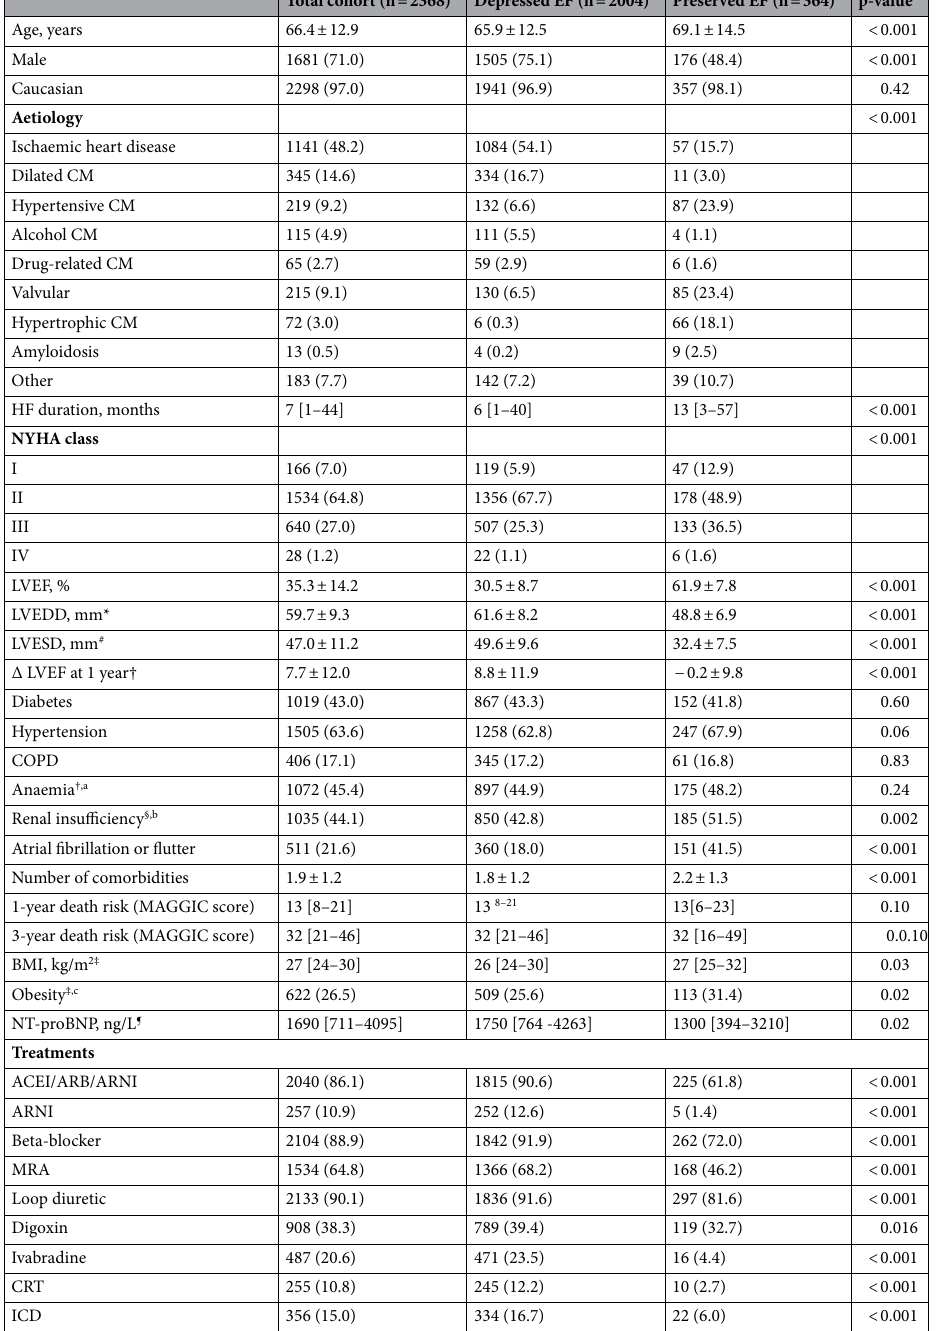
Table 1. Baseline demographic and clinical characteristics in patients with depressed and preserved ejection fraction (EF). Data are given as mean ± standard deviation, median [interquartile range], or n (%). *n = 2119; # n = 2083; † n = 1506; § n = 2361; ‡ n = 2345; ¶ n = 2350; ¥ n = 1665. ACEI, angiotensin-converting enzyme inhibitor; ARB, angiotensin II receptor blocker; ARNI, angiotensin receptor–neprilysin inhibitor; BMI, body mass index; CM, cardiomyopathy; COPD, chronic obstructive pulmonary disease; CRT, cardiac resynchronization therapy; HF, heart failure; ICD, implantable cardiac defibrillator; MAGGIC, Meta-analysis Global Group in Chronic Heart Failure; MRA, mineralocorticoid receptor antagonist; NT-proBNP, N-terminal pro-brain natriuretic peptide; NYHA, New York Heart Association. a According to World Health Organization criteria (< 13 g/dL in men and < 12 g/dL in women). b Estimated glomerular filtration rate (Chronic Kidney Disease-Epidemiology Collaboration equation) < 60 mL/min/1.73 m 2 . c Body mass index ≥ 30 kg/m 2